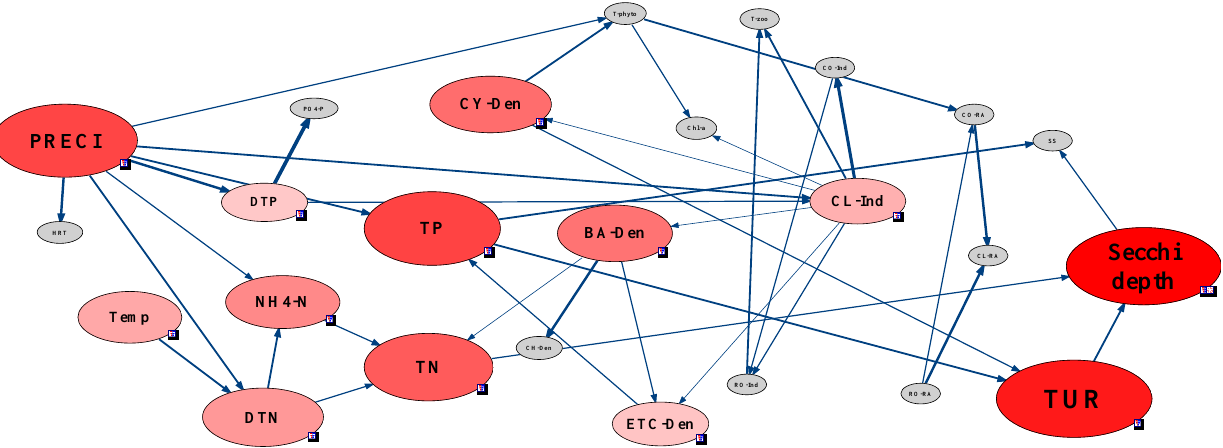
Figure 8. Sensitivity test and strength of influence analysis using the Bayesian network approach for assessing the CWP in St. 4, which was downstream of Gyeongan stream. All data for St. 4 used in the Bayesian network were discretized using the hierarchical method and bin count 3.